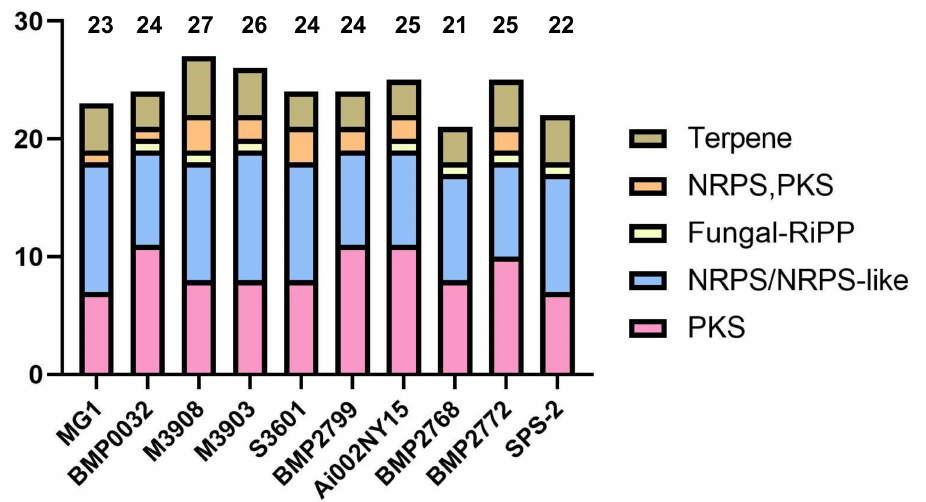
Figure 5. The number ( y -axis) and type of secondary metabolite BGCs in strain SPS-2 and other Alternaria strains deposited in the antiSMASH